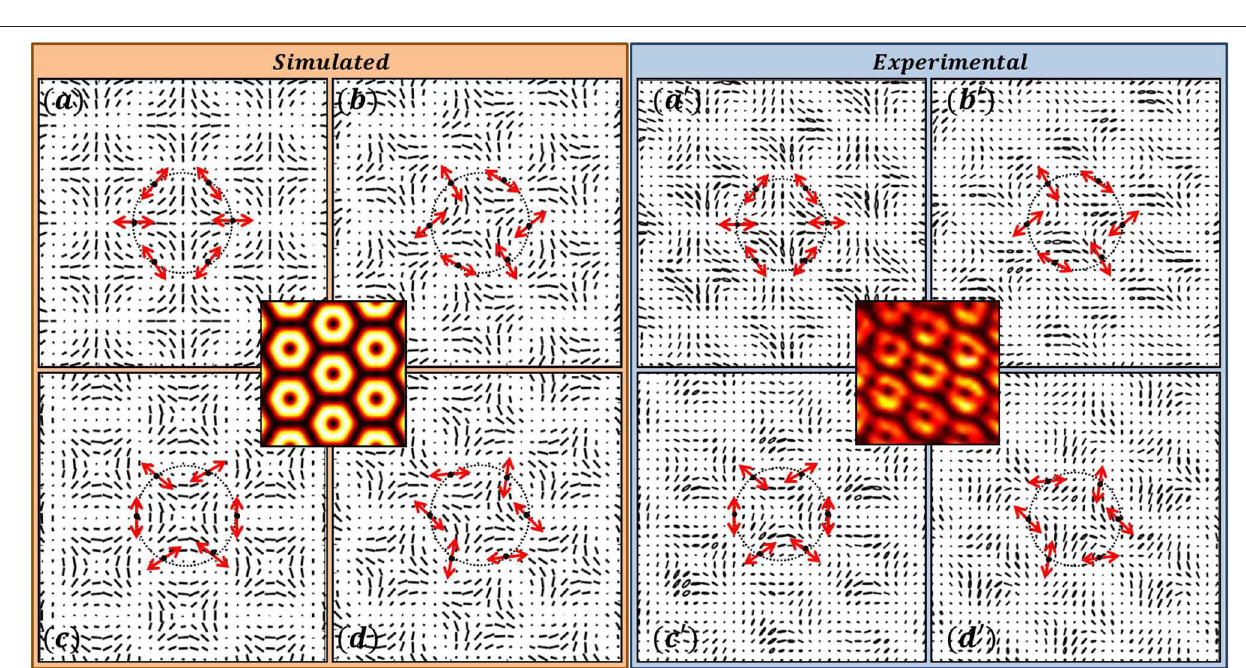
FIGURE 8 | Six Beam Interference producing lattice of V-points. The SOPs of the six plane waves are derived from a V-point with η = − 1. (a–d) Simulation; (a ′ –d ′ ) Experimental results.